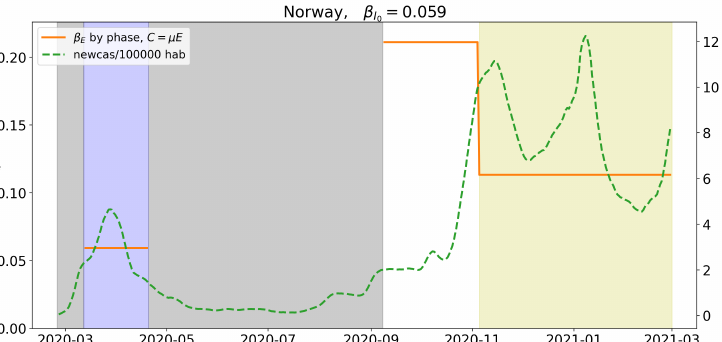
Figure 5. Value of β E for the different levels of lockdown. Blue background will correspond to Stage 1, red to Stage 2, yellow to Stage 3 and white to Stage 4. A green dotted line corresponds to the value of new cases per 100,000 hab.